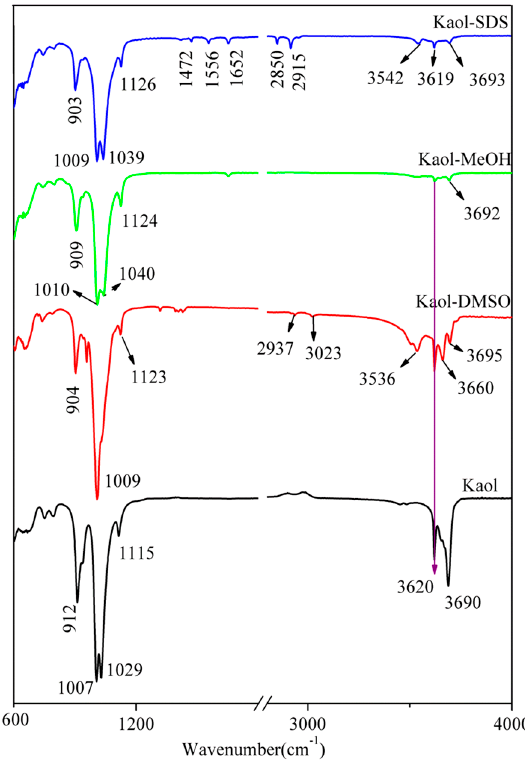
Figure 2. FTIR spectra of Kaol, Kaol-DMSO, Kaol-MeOH and Kaol-SDS.